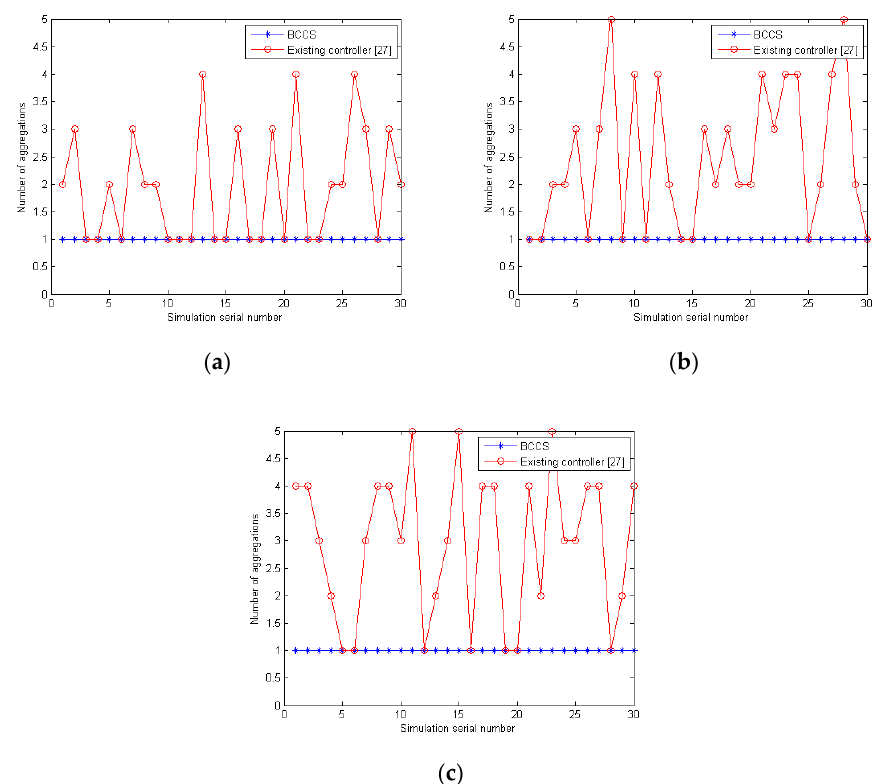
Figure 18. The comparison of the number of aggregations: ( a ) n = 9; ( b ) n = 16; ( c ) n = 25. ( a – c ) are three simulation